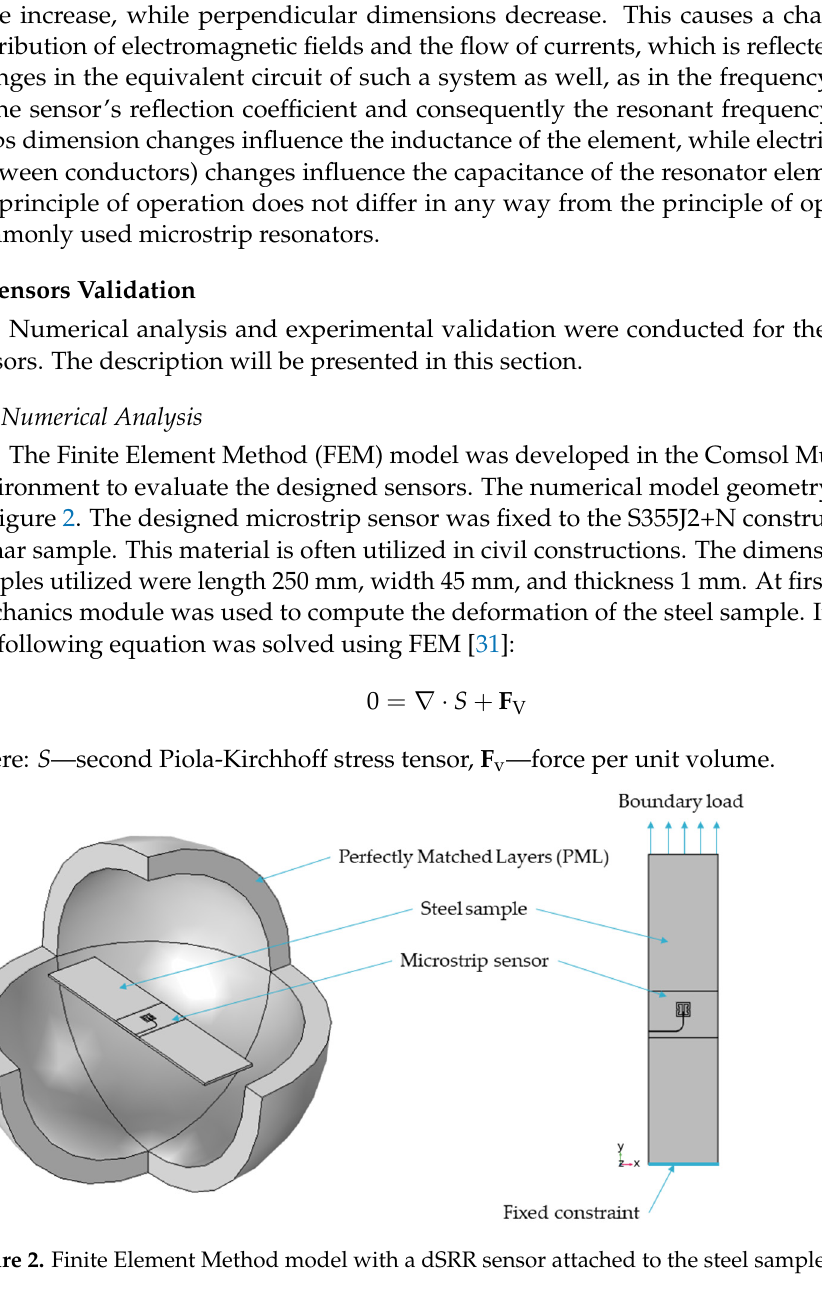
Figure 3. Calculated and measured module of reflection coefficient S 11 for considered sensors.